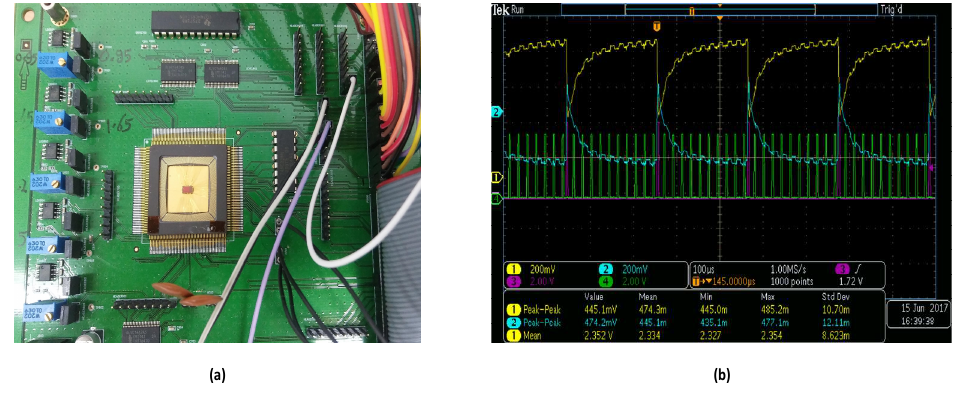
Figure 10. Measurement of the Integrator. ( a ) Test Board of the chip; ( b ) oscilloscope measurement of the integrator output.